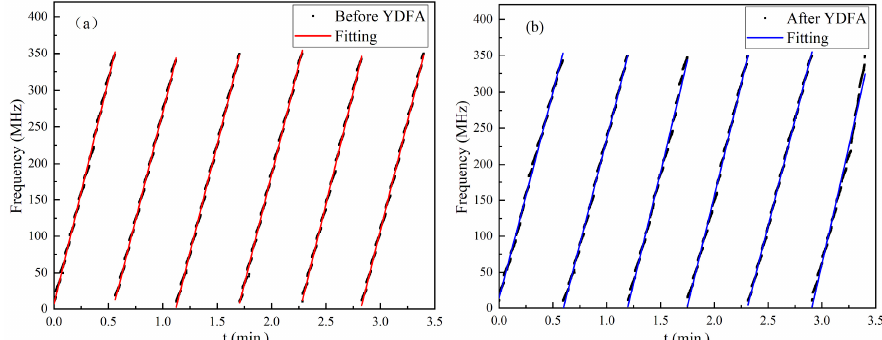
Figure 7. Frequency sweeping linearity of modulation ( a ) before and ( b ) after amplification.